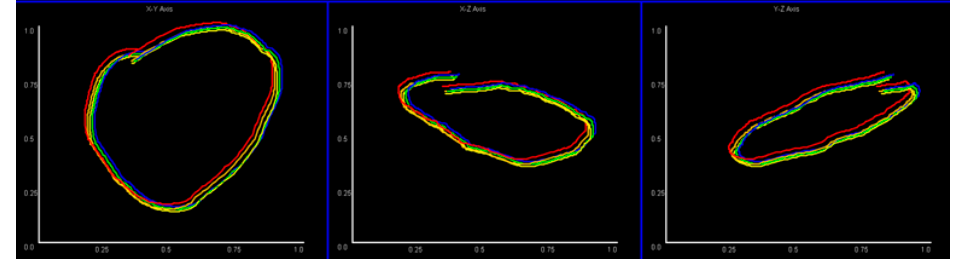
Figure 8. Real ‐ time interface of the gesture movement. The data has been normalized and these 5 colors represent five finger movements. The X ‐ Y, X ‐ Z, and Y ‐ Z plane’s gesture mapping are shown from left to right.